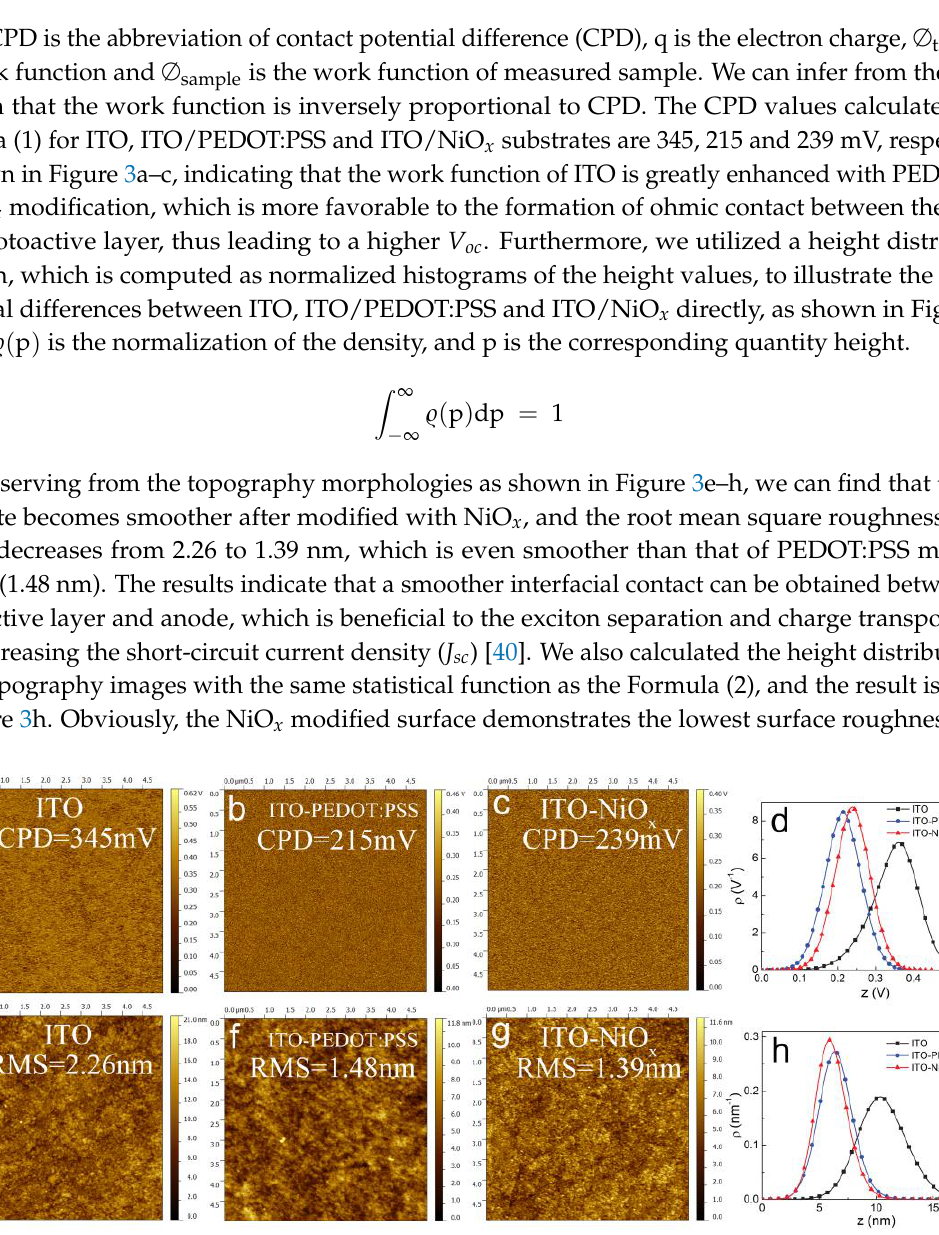
Figure 3. Contact potentials and AFM topography images of ( a , e ) ITO, ( b , f ) ITO/PEDOT:PSS and ( c , g ) ITO/NiO x (1.5 mg/mL); The normalization of the height density distributions of ( d ) contact potentials and ( h ) AFM topography images.